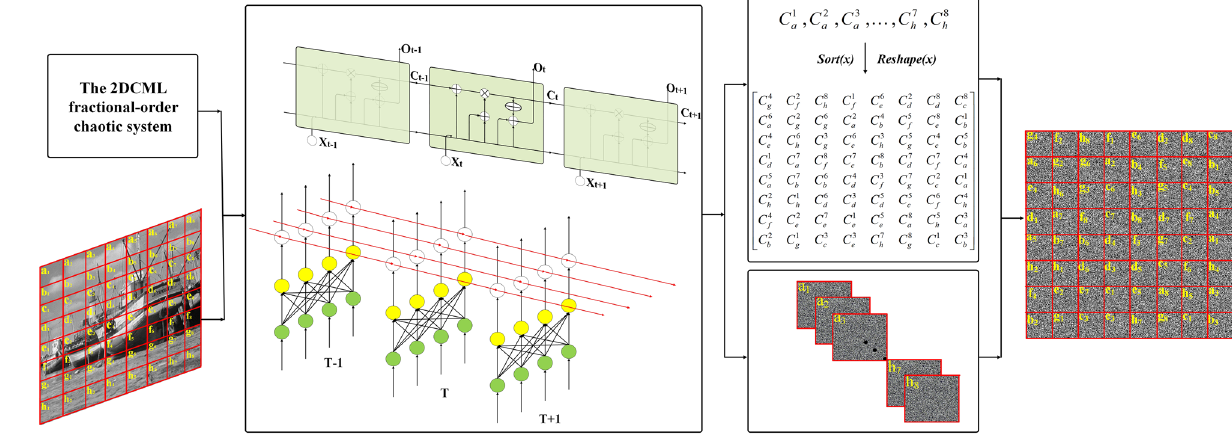
Figure 8. The encryption process.